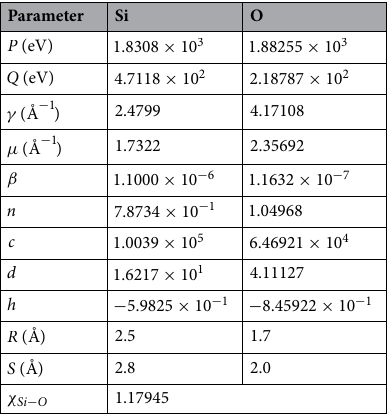
Table 2. Parameters in the Tersoff potential for the solid phase. Parameters in the Tersoff potential for the solid phase are from 38,39 .